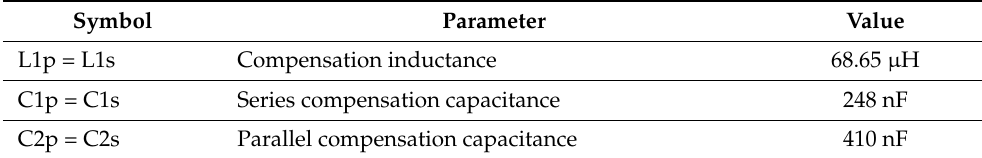
Table 5. LCC resonant compensation network